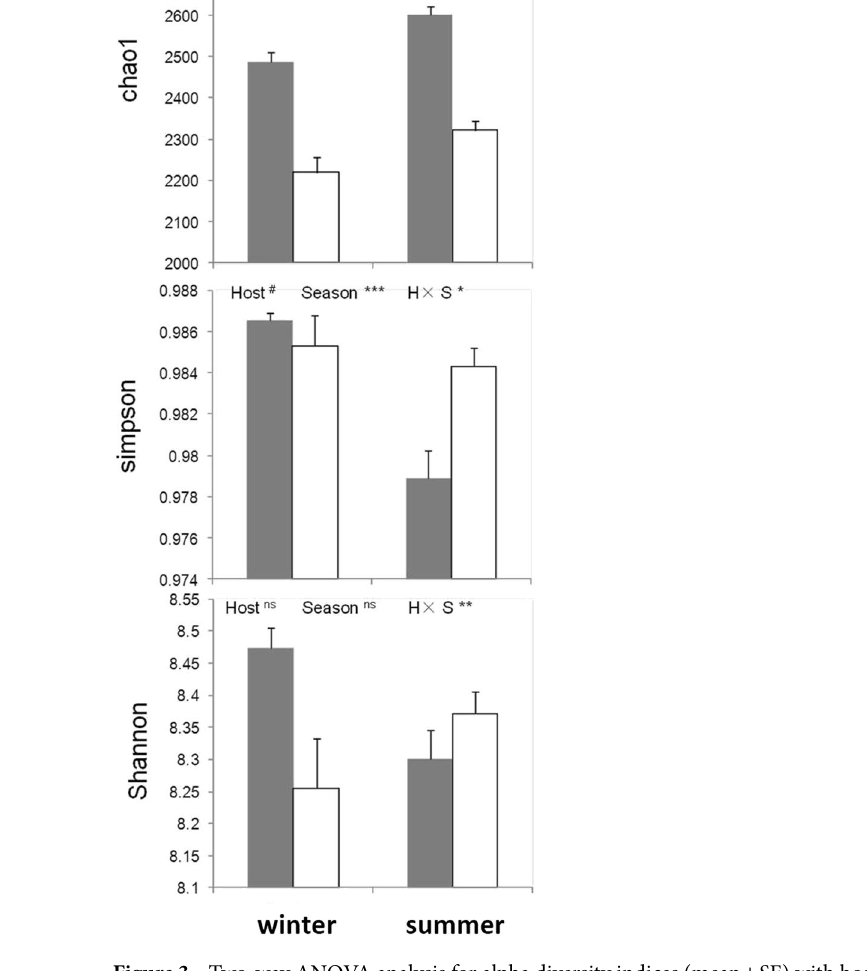
Figure 3. Two-way ANOVA analysis for alpha diversity indices (mean ± SE) with host and season. Gray bars represent the data of yaks and white bars represent Tibetan sheep. *P < 0.05; **P < 0.01; ***P < 0.001; # P <